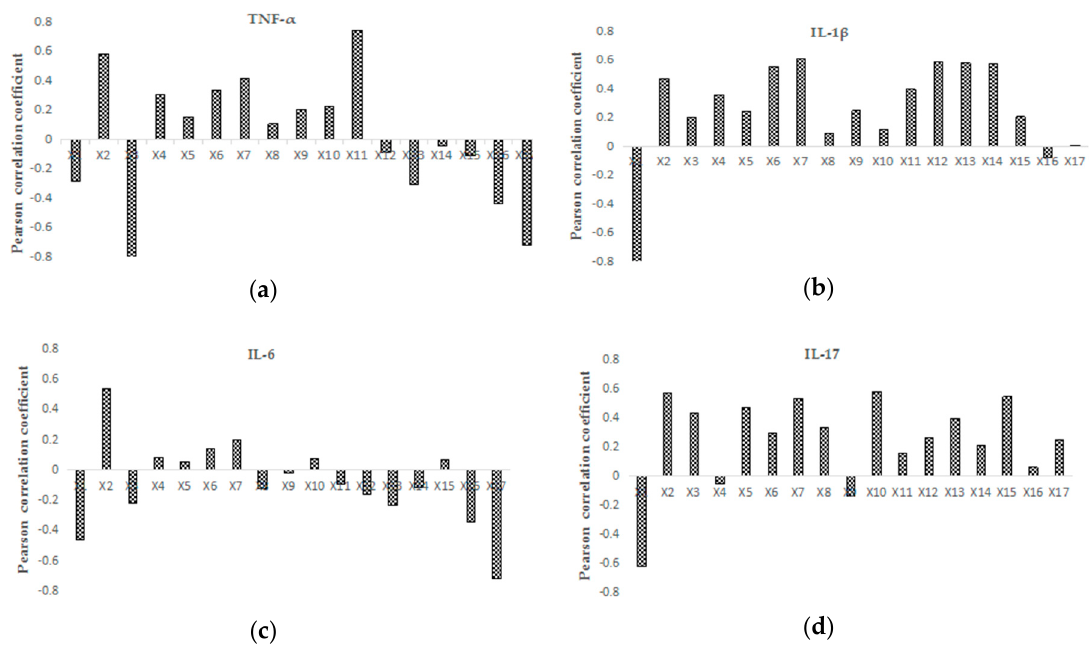
Figure 5. Pearson correlation coefficients between the peak area and inflammatory markers, ( a ) TNF- α ; ( b ) IL-1 β ; ( c ) IL-6; and ( d ) IL-17.